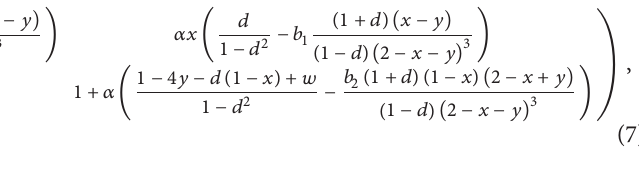
= 𝑏 = 0.2 . (c) Critical curves of rank-0, LC 1 2 ) , for the same parameter values as in panel (c). These curves −1